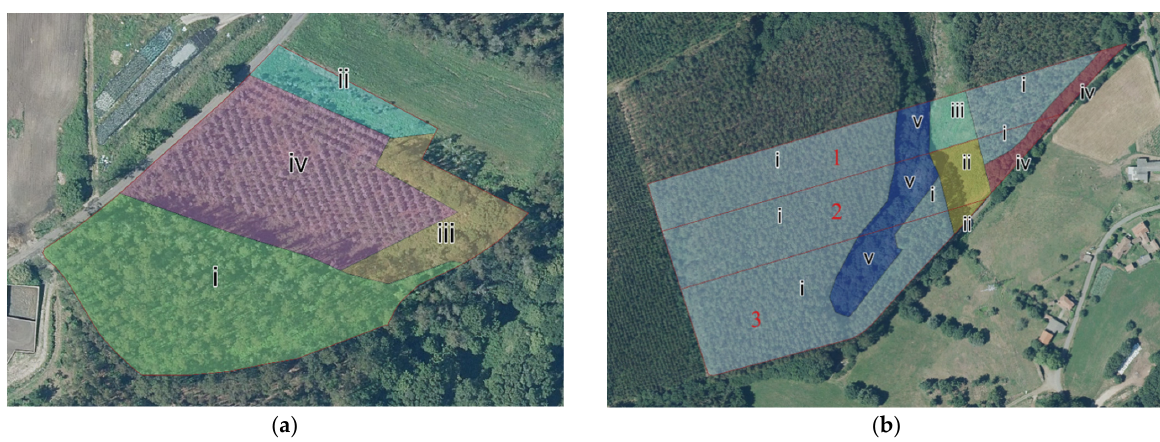
Figure 2. Example of some plots with different uses, forest species and cutting ages. ( a ) Plot of 1.26 ha and (i) reforestation of E. globulus close to the cutting age (0.56 ha); (ii) recent reforestation of E. globulus less than 1 year old (0.08 ha); (iii) scattered deciduous hardwoods with scrub (0.15); (iv) repopulation of 5-year-old E. globulus (0.47). ( b ) Three plots with (i) reforestation of E. globulus , regular masses of the same year (plot 1: 1.5 ha; plot 2: 1.36 ha; plot 3: 1.68 ha); (ii) pasture forage crop (plot 2: 0.26 ha; plot 3: 0.04 ha); (iii) scrub (plot 1: 0.2 ha); (ii) and (iii) tree covers cleared by a power line); (iv) Quercus robur (plot 1: 0.12 ha; plot 2: 0.12 ha); (v) riparian vegetation (plot 1: 0.16 ha; plot 2: 0.25 ha; plot 3: 0.3 ha).